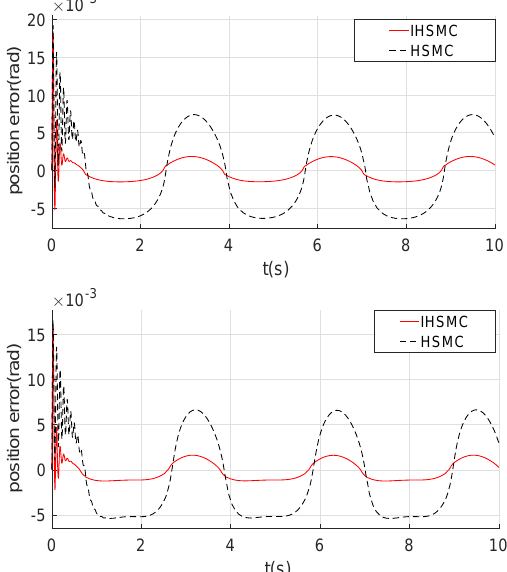
Figure 2. Improved hierarchical sliding mode control (IHSMC) and HSMC position tracking comparison curve.